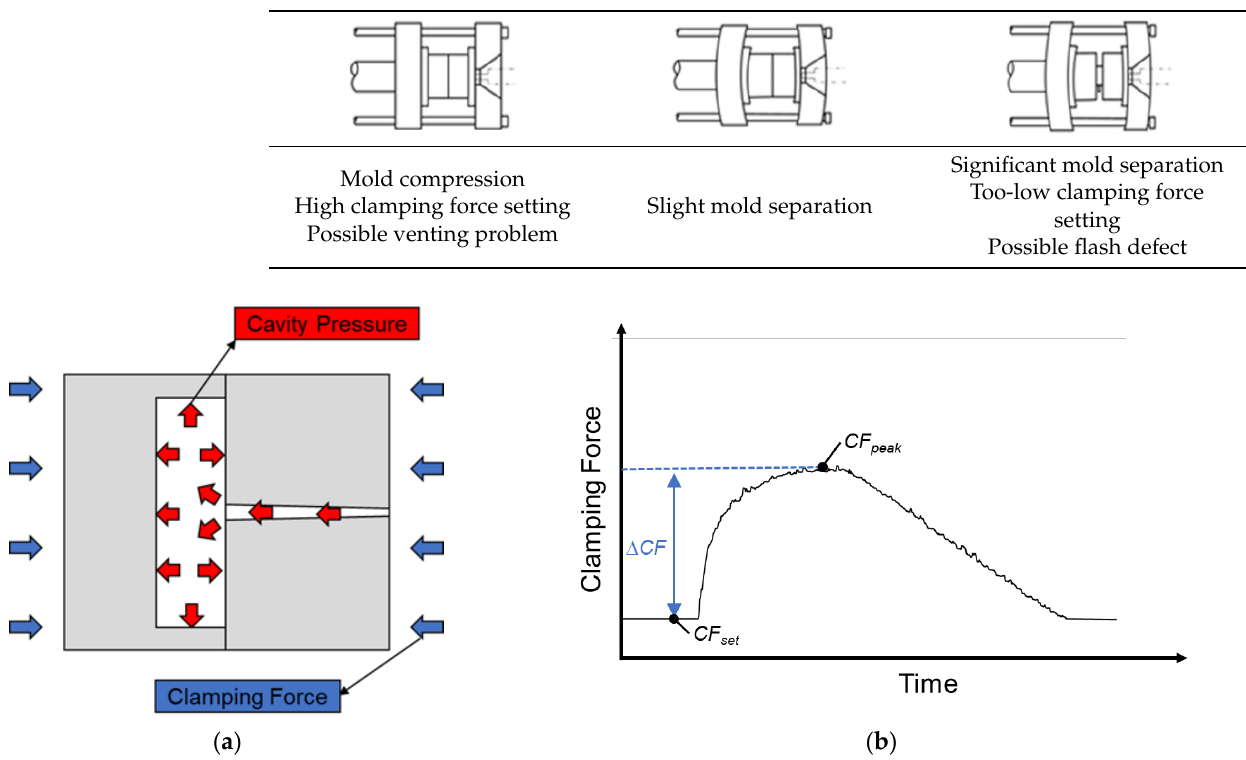
Table 1. Status of mold separation [7].